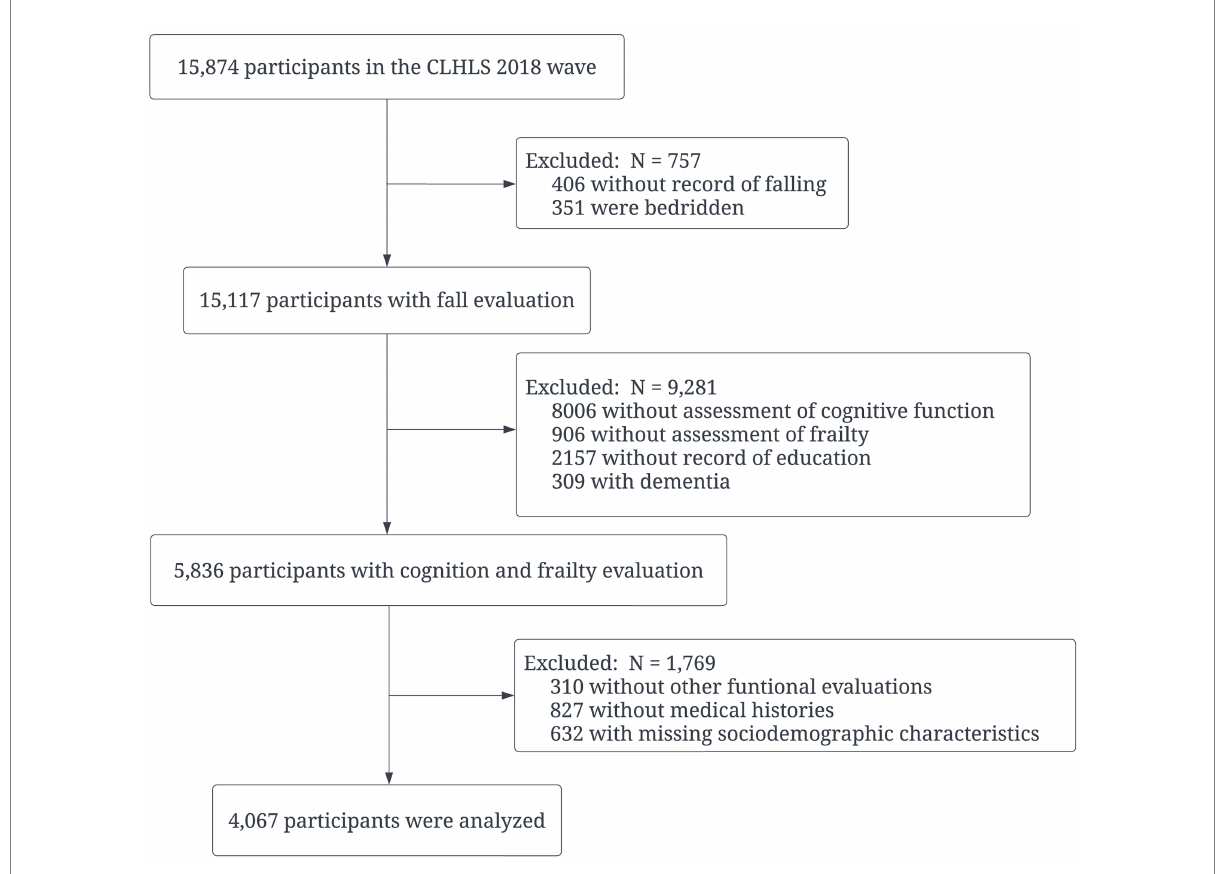
FIGURE 1 Flow chart of participants selection. CLHLS: Chinese Longitudinal Healthy Longevity